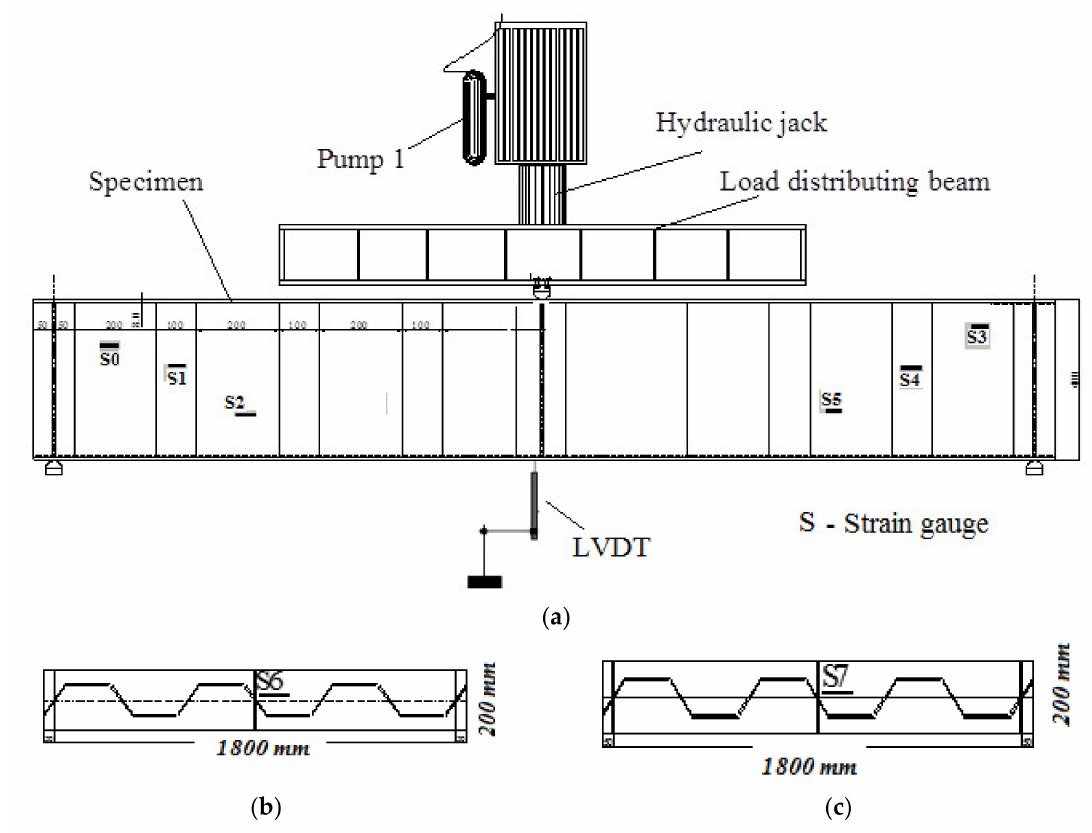
Figure 7. Instrumentations and Test setup: ( a ) Test setup and Locations of flange stiffeners and strain gauges in specimens; ( b ) Gauge in top surface of top steel flange; ( c ) Gauge in bottom surface of bottom steel